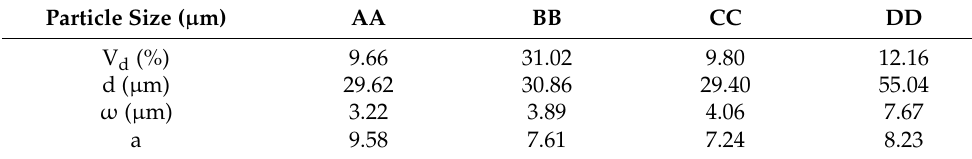
Table 2. The parameters of particle size distribution of HGM-T60